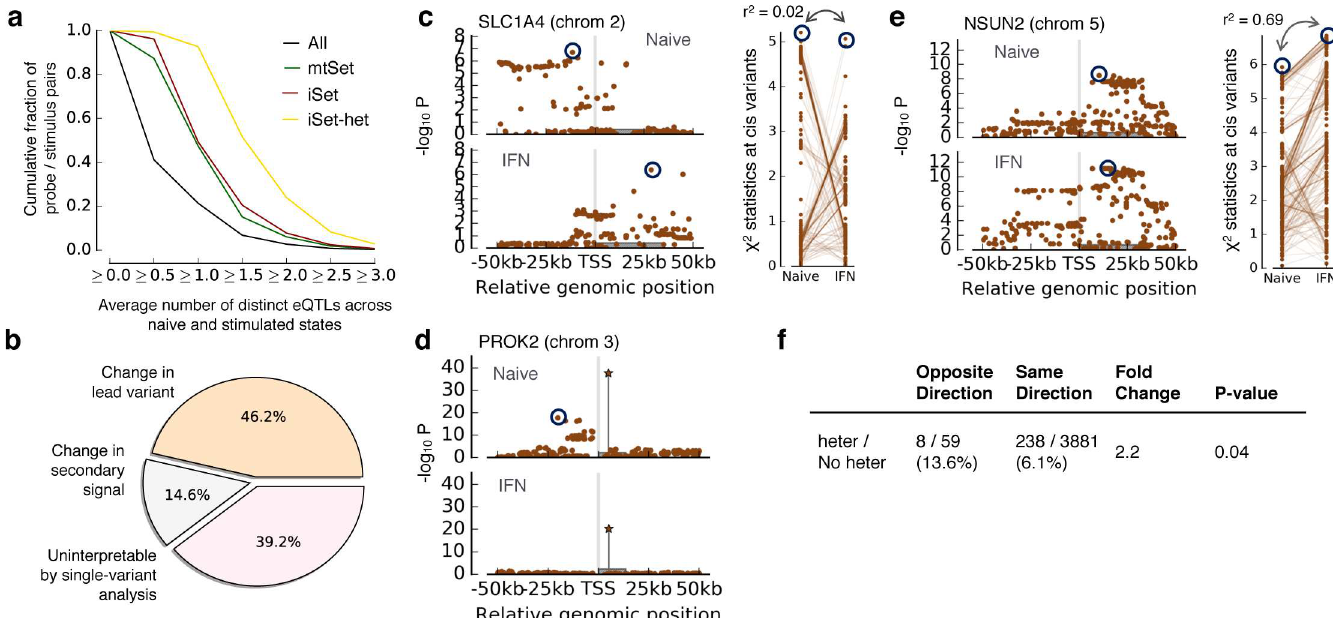
Fig 4. Characterization of genes with significant heterogeneity GxC for stimulus eQTLs in monocytes. (a) Cumulativefractionof probe/stimulus pairs with increasingnumbersof distinct univariateeQTLs (averageof the na ï veand the stimulated state usingstep-wiseselection)for differentgenesets ( Methods ).Shownare cumulative fractions of all probe/stimulus pairs (All), those with significant cis associations(mtSet), pairswith significantGxC (iSet) and instanceswith significant heterogeneity GxC (iSet-het). (b) Breakdown of 1,281 probe/stimulus pairswith significantheterogeneity GxC intodistinct classes definedusingthe results of a single-variant step-wiseLMM ( Methods ). (c-e) Manhattanplots for representative probeswith significant heterogeneity GxC effects. Grey boxesindicatethe genebody. (c) Manhattanplot(left) and χ 2 statistics for variantsin bothcontexts (right)for the gene SLC1A4 .Dark circles indicatedistinctleadvariantsin both contexts(r 2 < 0.2). (d) Manhattanplotafter conditioning on the leadvariant(secondaryassociations in the stepwiseLMM) for the gene PROK2 .The star symbolindicatesthe sharedleadvariantin bothcontexts. The conditionalanalysisrevealsa secondaryassociation that is specificto the na ï vestate. (e) Analogousplot as in c for the gene NSUN2 ,for whichthe single-variantmodeldid not providean interpretation of heterogeneity- GxC. (f) Breakdownof probe/ stimuluspairswith sharedleadvariants, stratified by concordance of the effect direction(opposite-directionversus same- directioneQTLs) and significance of the heterogeneity-GxC test (hetervs No heter; FDR 5%). eQTLs with oppositeeffects were enriched for significant heterogeneity-GxC (2.2 fold enrichment, P < 4e-2).